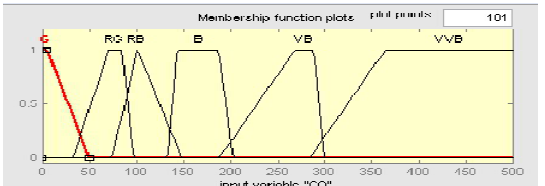
Fig. 4. Diagram of sulfur dioxide membership function Fig. 5. Diagram of carbon monoxide membership function